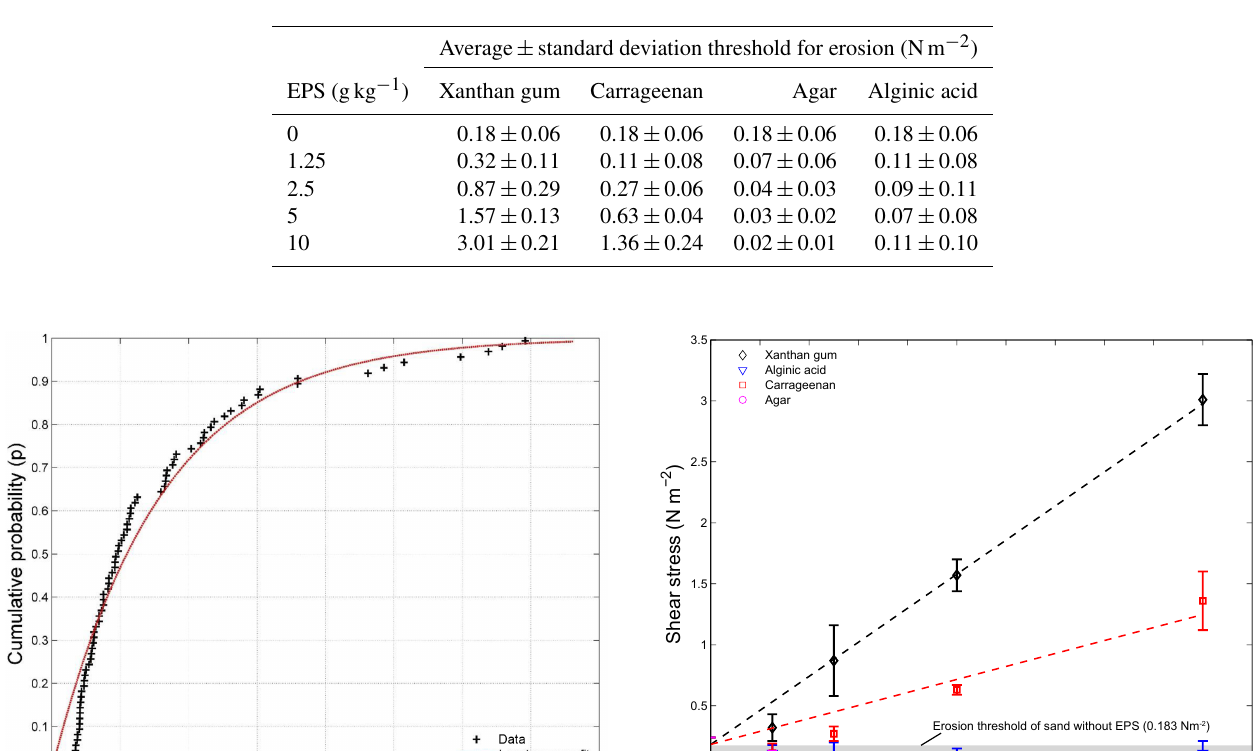
Table 1. Threshold for erosion of four extracted EPSs measured with the CSM erosion device. Statistics calculated from n = 5 repeat measurements.